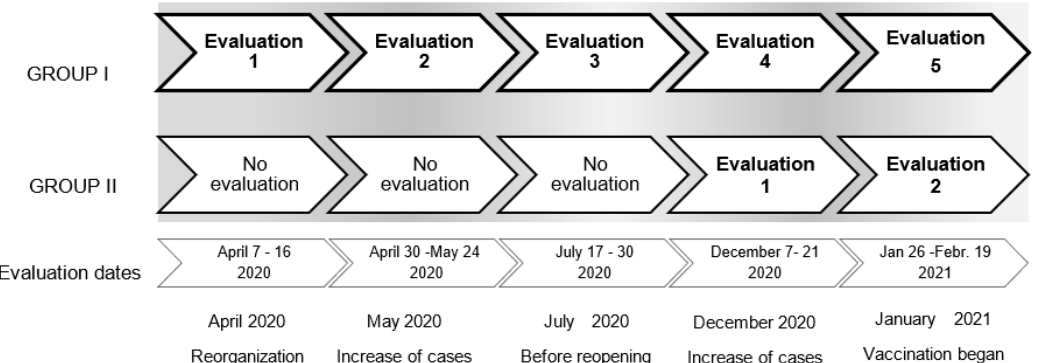
Figure 1. Time points of evaluation during follow ‐ up of the participants included either at the first epidemic wave (Group I) or the second epidemic wave (Group II). Group